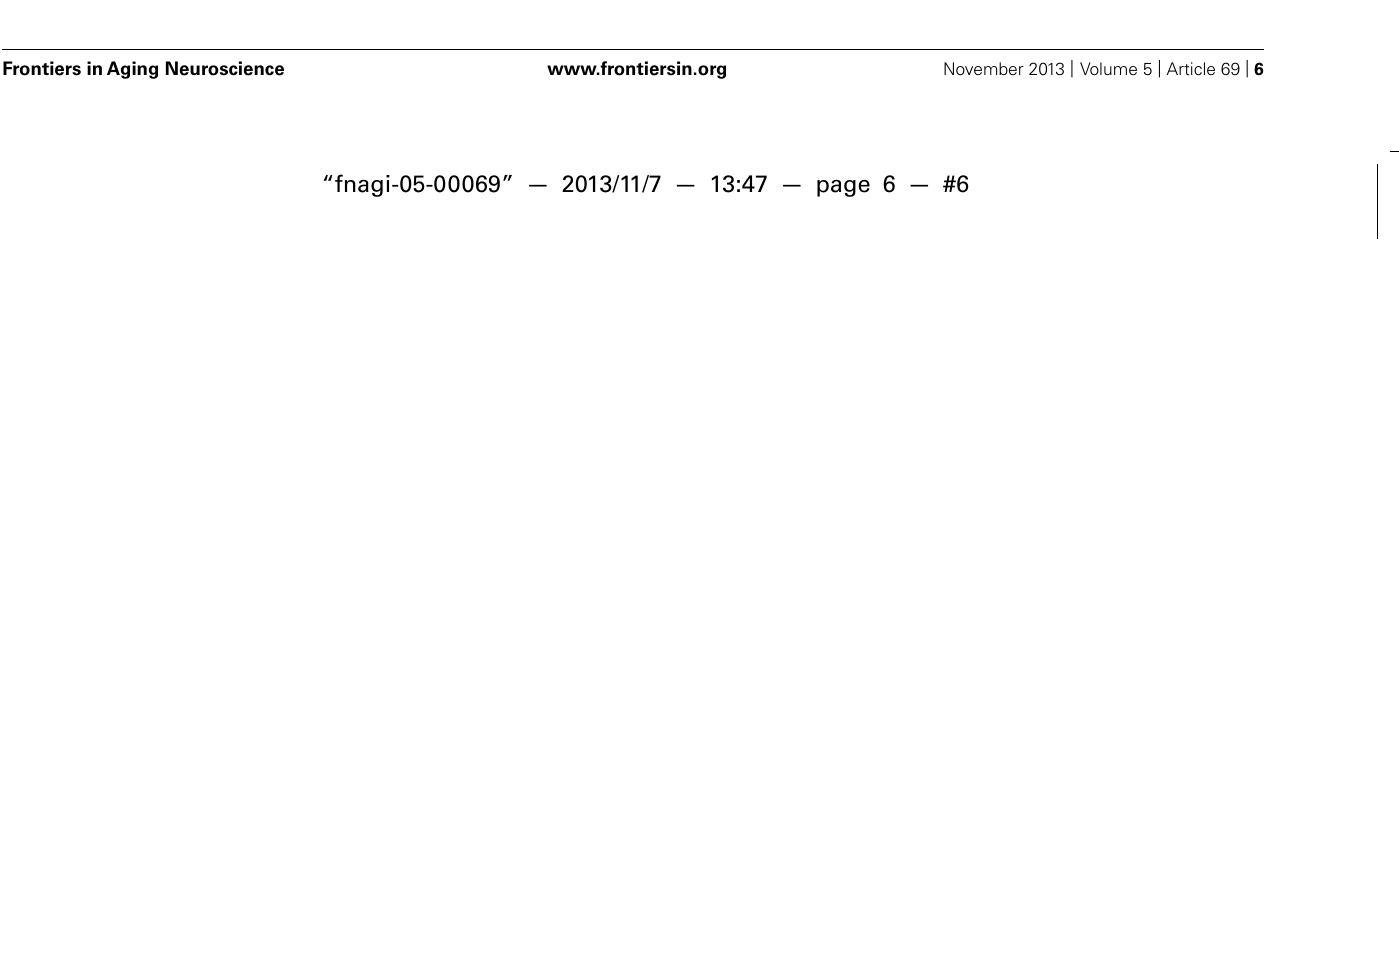
comparison of micrographs from a (C) 15 year old parvocellular layer 3 with a (D) 35 year old parvocellular layer 3 show similar increases.The left side of this image corresponds to the medial aspect and the top to the dorsal aspect of the sections. Scale bar = 150 μ